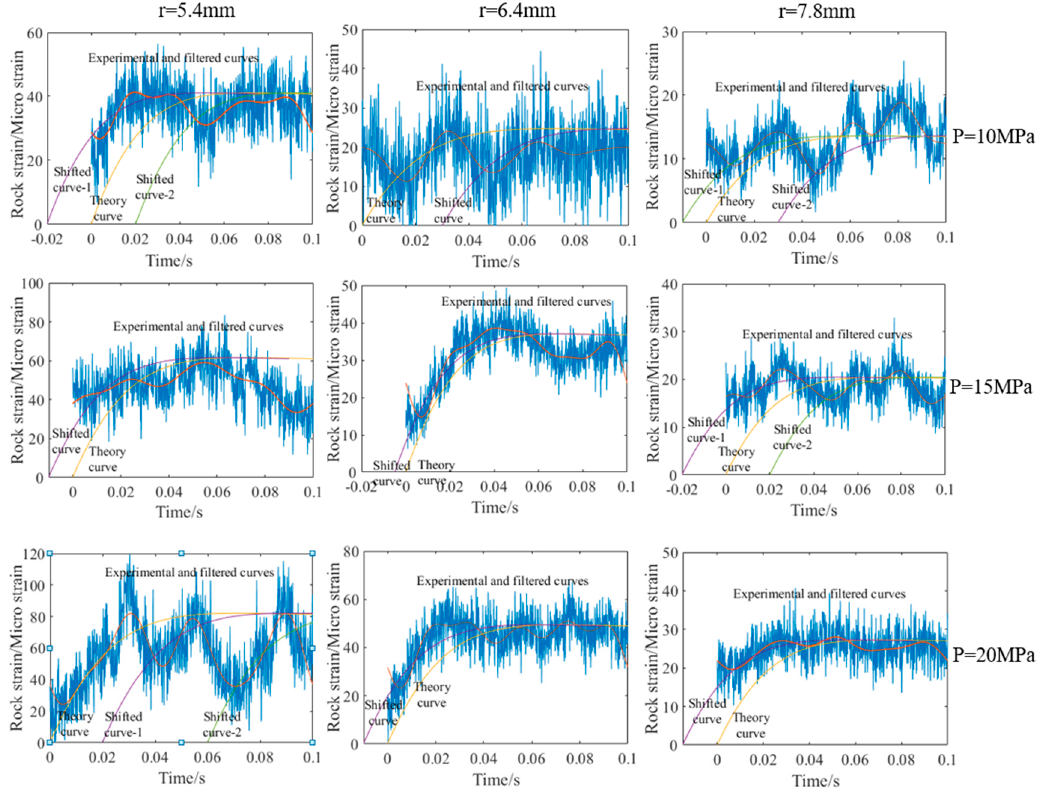
Figure 10. Comparison diagrams of theoretical and experimental